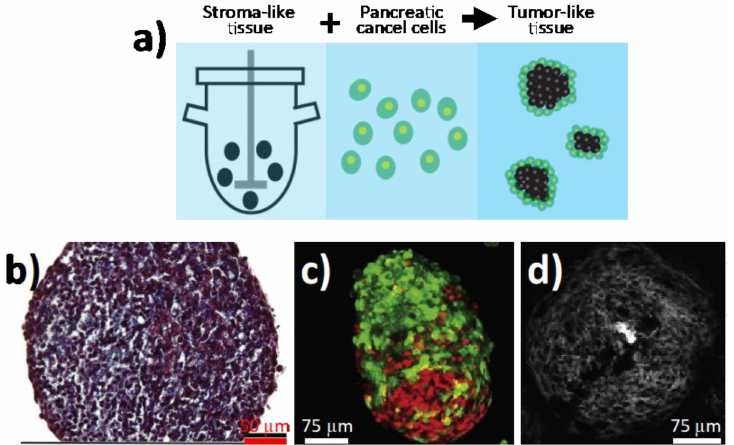
Figure 3. Bioengineered tumoral microtissues recapitulate desmoplastic reaction. ( a ) Schematic representation of the approach used for developing 3D in vitro PDAC bioreactor models. Stromal microtissues are produced by co-culturing normal fibroblasts or cancer-associated fibroblasts (CAFs) with gelatin microscaffold in a spinner bioreactor. After 6 days, PC cells (PT45) are added and the culture is stopped at day 12 for collecting PDAC microtissues in order to perform further investigations. ( b ) Masson’s trichrome staining and ( c ) confocal imaging for CAF/PT45 microtissues at day 12 of culture. ( d ) Second harmonic generation signal (gray scale) from newly formed fibrillar collagen in CAF/PT45 microtissues (adapted from